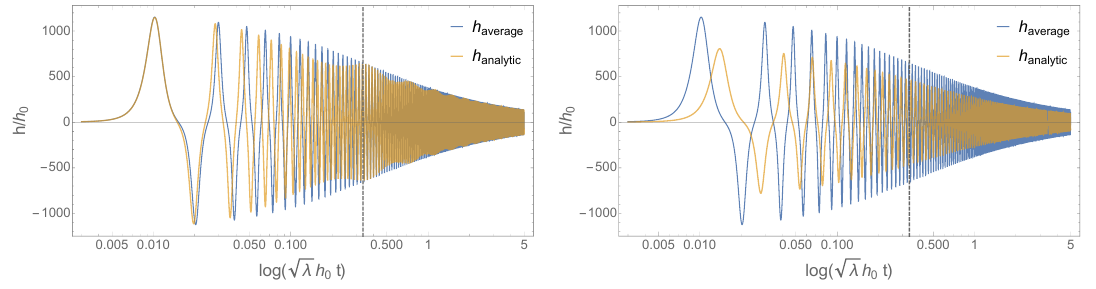
= (cid:3) (left panel) and I